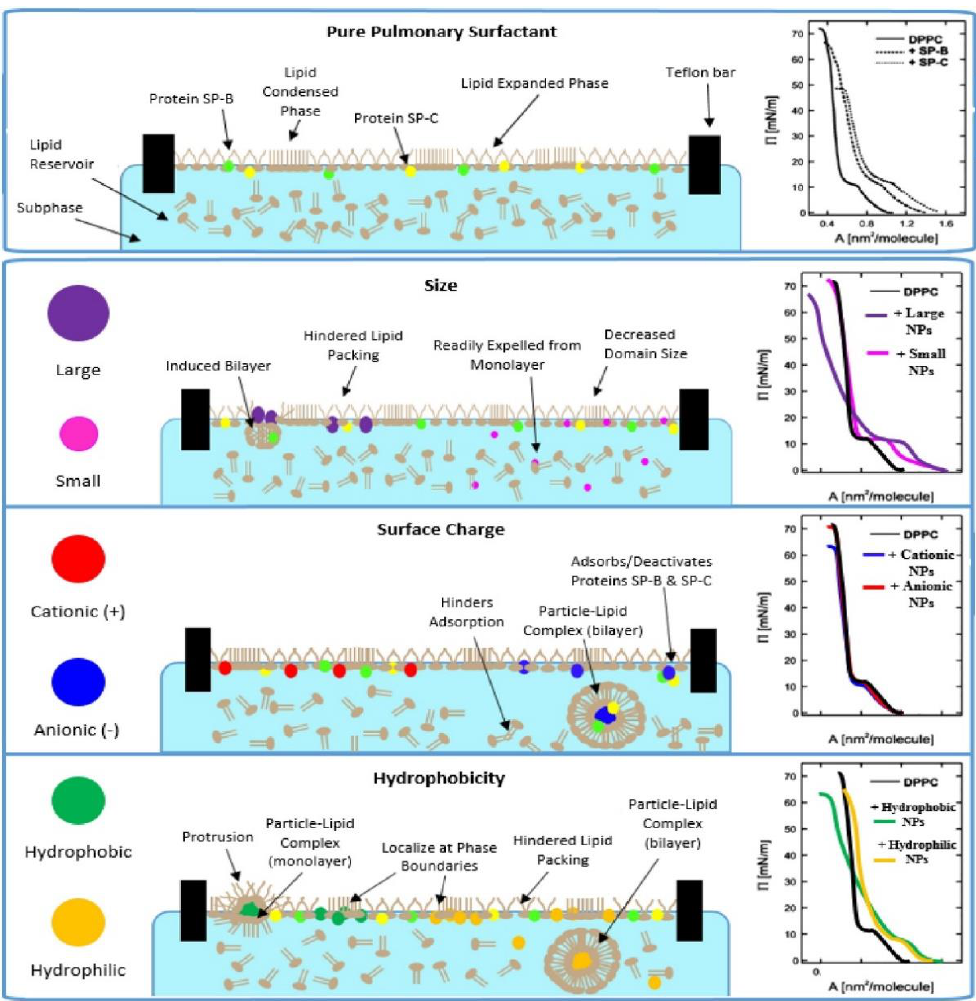
Figure 7. Schematic representation of the effect of different types of particles in the interfacial organization of LS layers, and the surface pressure-area per molecule isotherms. Reprinted from Arick et al. [65] , with permission from Elsevier, Copyright 2015.